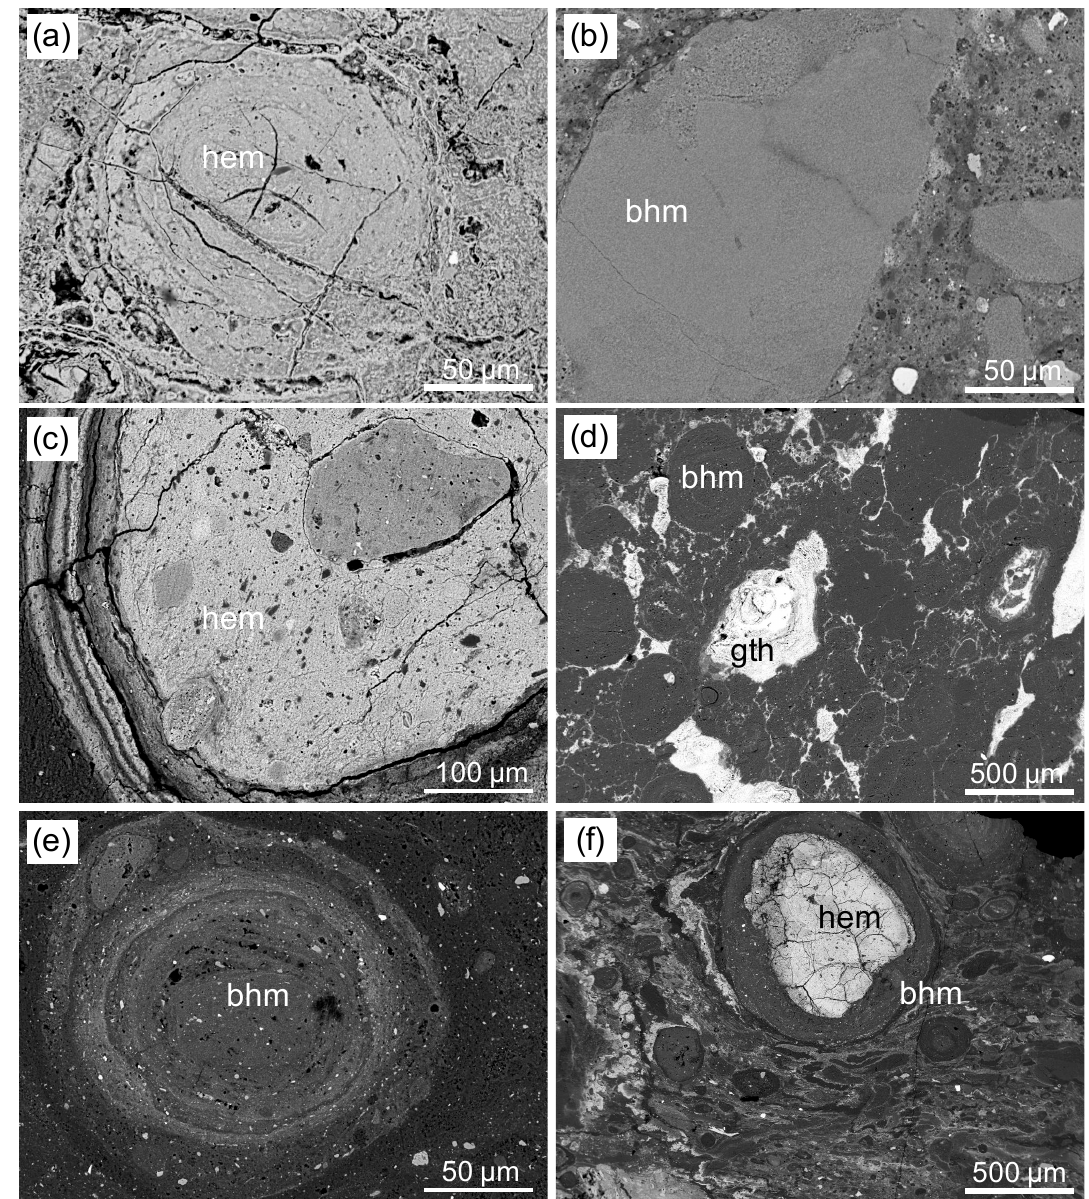
Figure 3. SEM (backscattered ‐ electron) micrographs: ( a ) LBP 7: nucleus of a hematitic oolite, ( b ) LBP 7: boehmite ‐ rich clasts, ( c ) Vil_IV5: complex hematitic oolite, ( d ) LUP_A4: goethite crusts and dendrites (bright) between the Al ‐ hydroxides oolites (dark), ( e ) LUP_A15: boehmite oolite, ( f ) LUP_A15: oolite showing a hematite nucleus, and a boehmite rim, in a matrix of boehmitic micro ‐ oolites showing compaction features. bhm = boehmite, hem = hematite, gth = goethite.